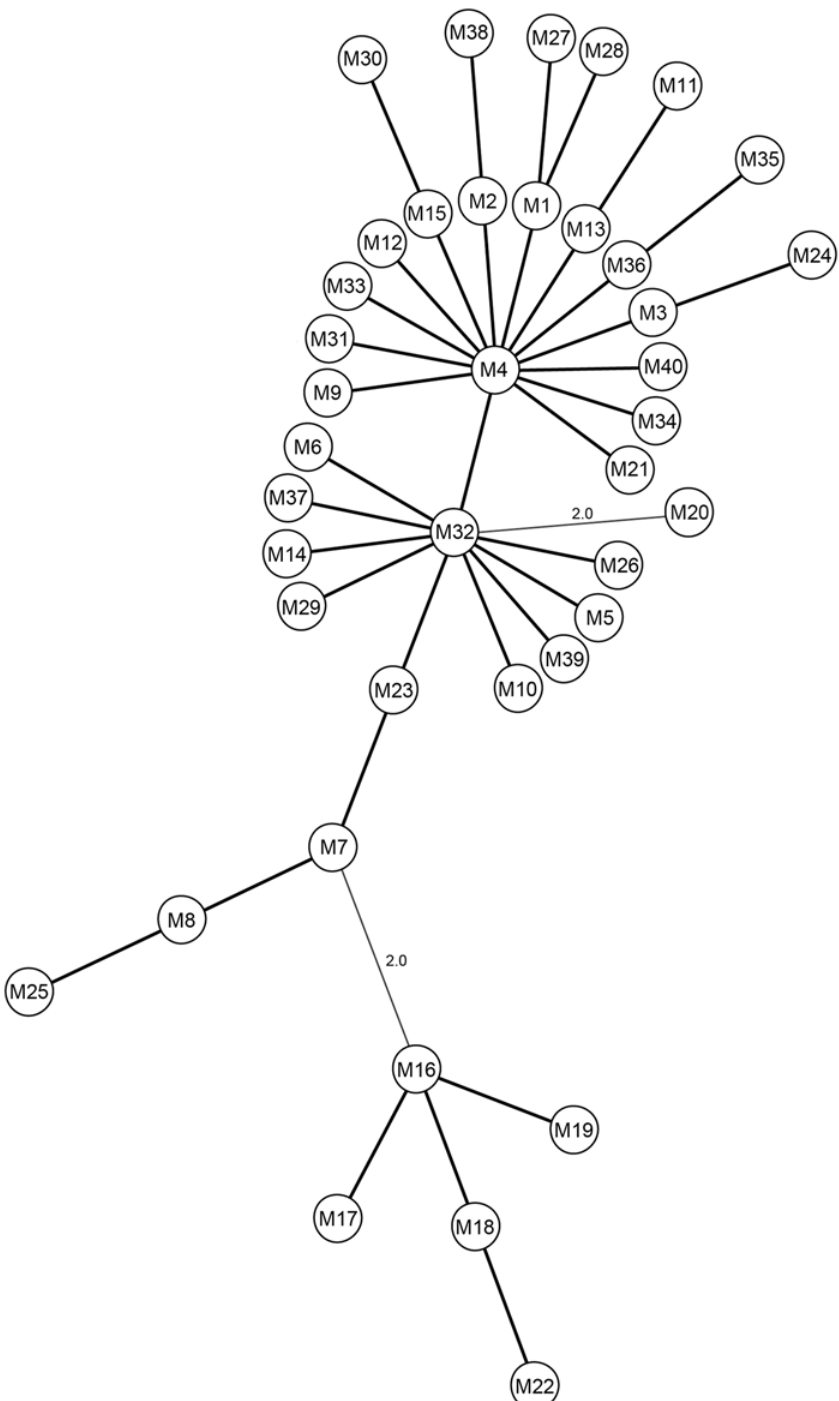
Fig 2. Minimum spanning tree (MST) based on the SSR profiles of the 4 loci for all 40 SSR-types identified in the current study. The tree was generated using the BioNumerics 7.1 multilocus sequence typing program and the circles represent the M1-M40 SSR-types. Thick lines represent only one variation amidst the 4 loci, whereas thin lines represent 2 differences between the 4 loci, the latter of which is indicated.